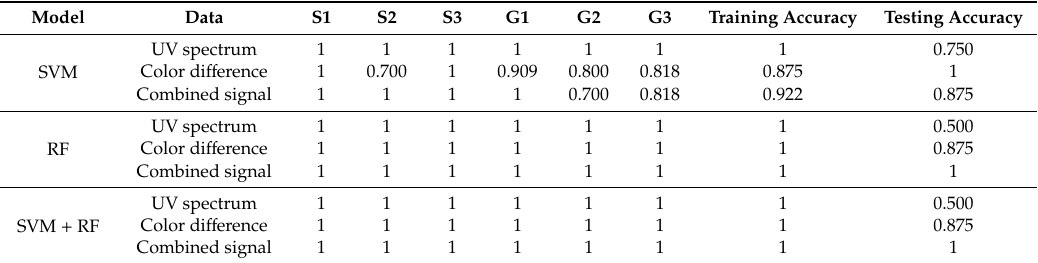
Table 1. The classification results based on UV spectrum, color di ff erence, and combined signal using the three models.